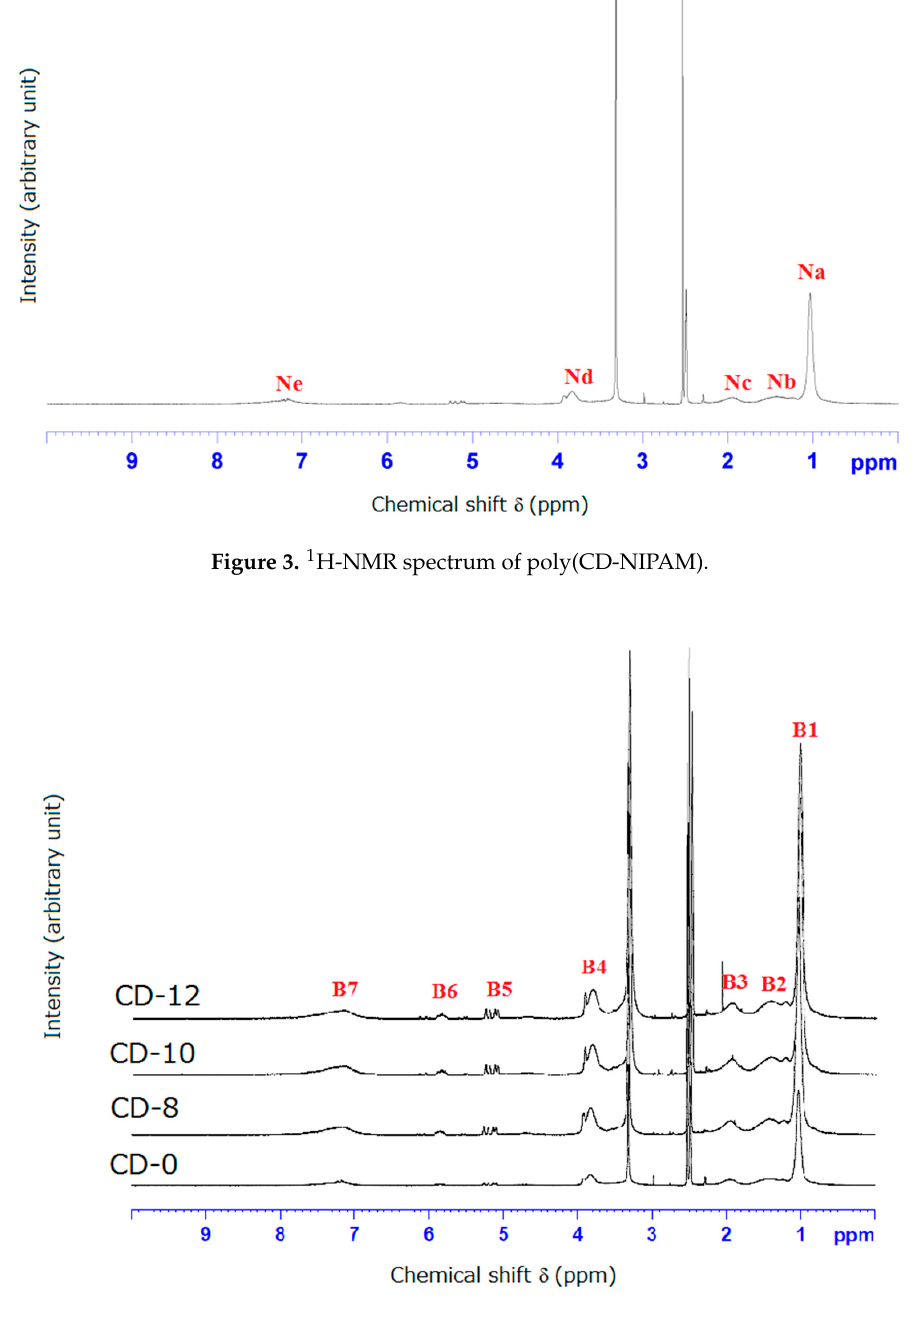
Figure 4. 1 H-NMR spectra of poly(CD-NIPAM-IAM) copolymers.